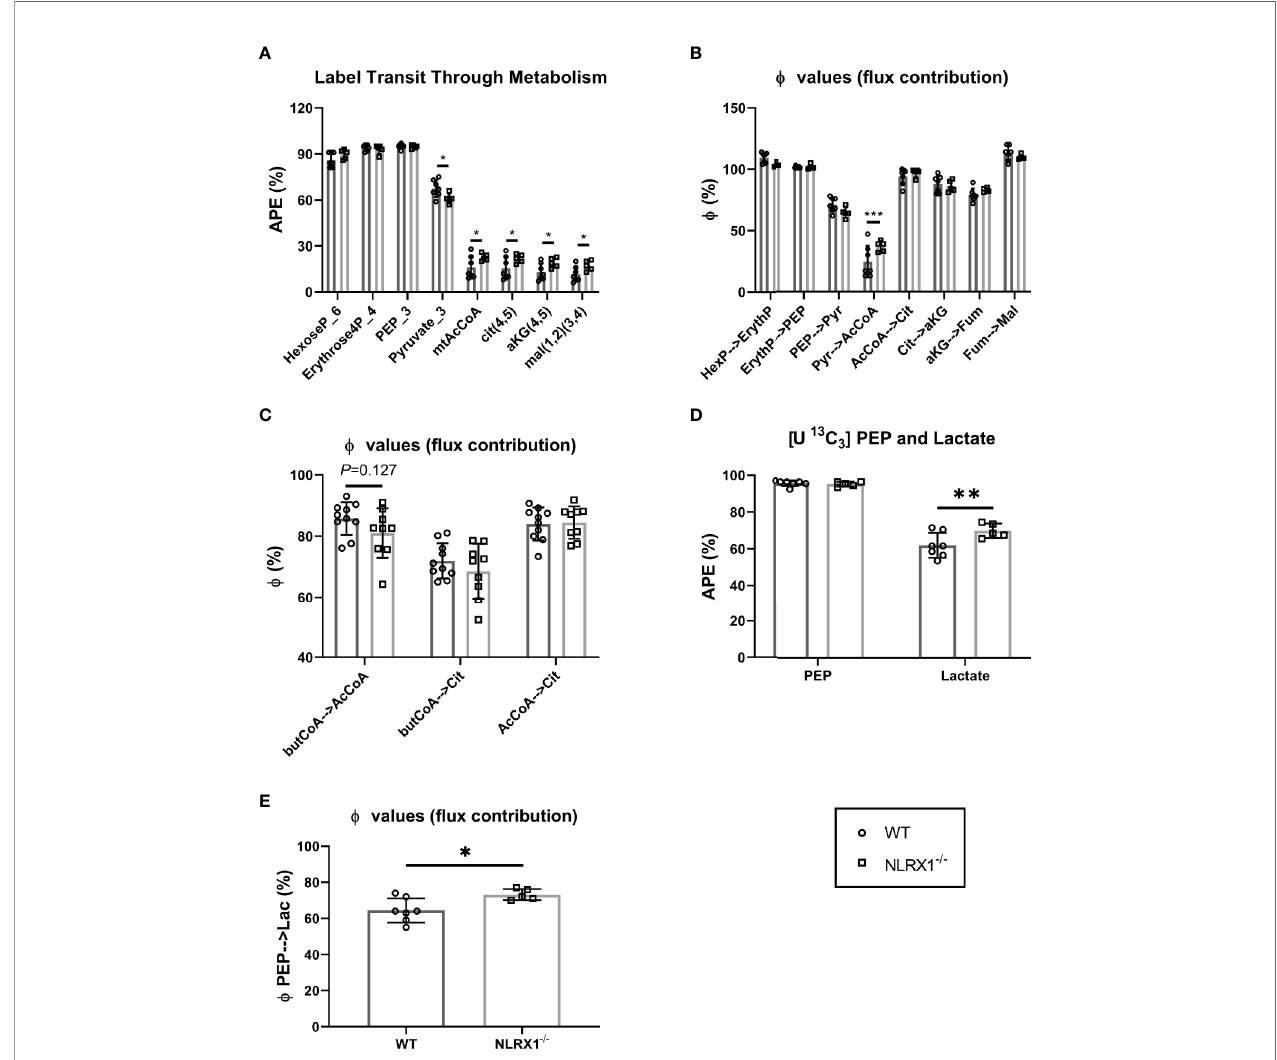
FIGURE 5 | Metabolism of isolated beating WT and NLRX1 -/- hearts characterized following 35 min perfusion with U- 13 C 6 labeled 5.5 mM glucose or U- 13 C 16 0.4 mM palmitate. (A) Metabolite sequential enrichment in glycolysis (hexose-6-phosphate, PEP, pyruvate), pentose phosphate pathway (erythrose-4-phosphate), pyruvate dehydrogenase (PDH) complex reaction (mtAcCoA) and TCA cycle (citrate, a -ketoglutarate and malate) from 13 C glucose. The mitochondrial enrichments re fl ect the calculated contributions of carbons coming from acetyl CoA in the fi rst turn; (B) Flux contribution ( f ;), depicted as the ratio of precursor to product enrichment, determined by MIMOSA analysis along central carbon metabolism with each “ parent ” metabolite giving rise to its respective direct or clustered isotopomer(s); (C) Flux contribution of the 13 C palmitate-derived labeled butyrylCoA into acetylCoA or citrate, and acetylCoA into citrate. (D) 13 C labeling in PEP and lactate; (E) Flux contribution of the glycolytic intermediate PEP to lactate as proxy for lactate generation; APE(%), atomic percent enrichment (=(labeled isotopomer/ total metabolite) * 100); PEP = phosphoenolpyruvate, Values represent mean ± SD (n= 5-10 per group). * P < 0.05, ** P < 0.01, *** P < 0.001, by two-way ANOVA followed by LSD test or by t